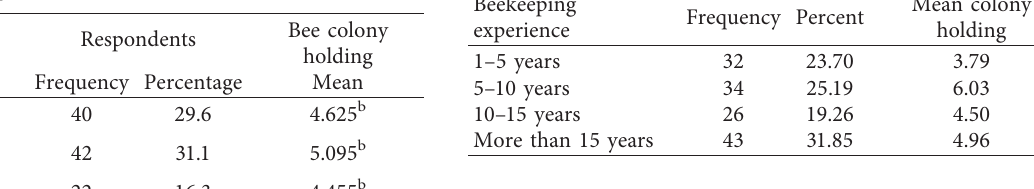
Table 2: Educational status and mean bee colony holding of the interviewed beekeepers.